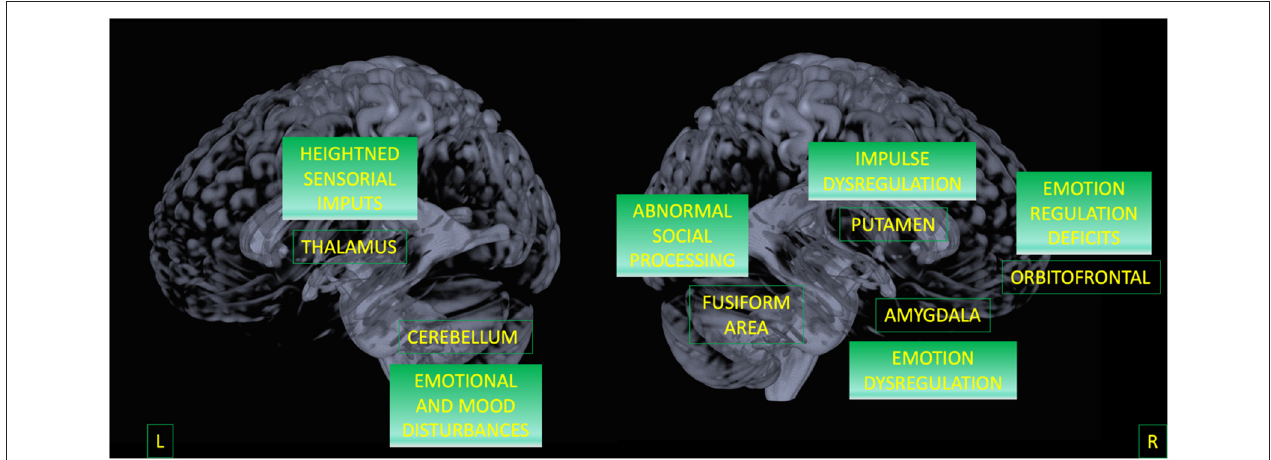
FIGURE 3 | A model for BPD circuit. Areas surviving both contrasts (BPD against HC, and BPD against BD) are displayed as well as their potential functional